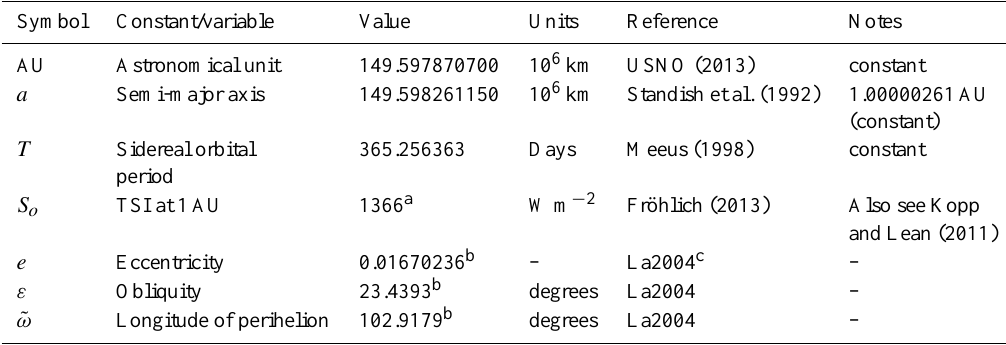
Table 1. Summary of constant and variable model input